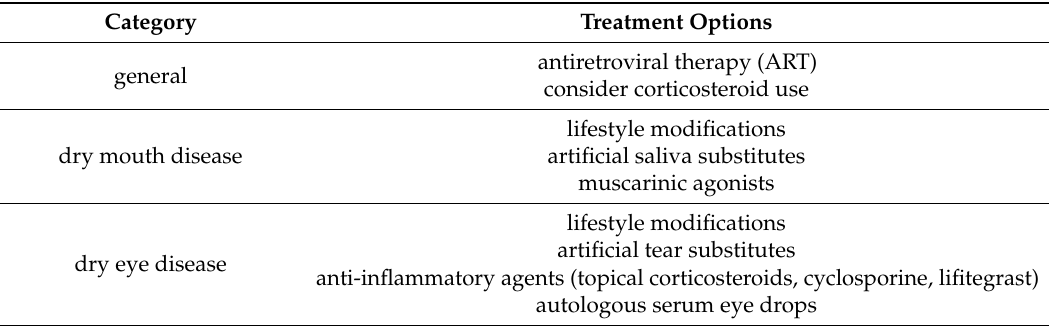
Table 5. Current approaches to exocrine gland dysfunction as a consequence of